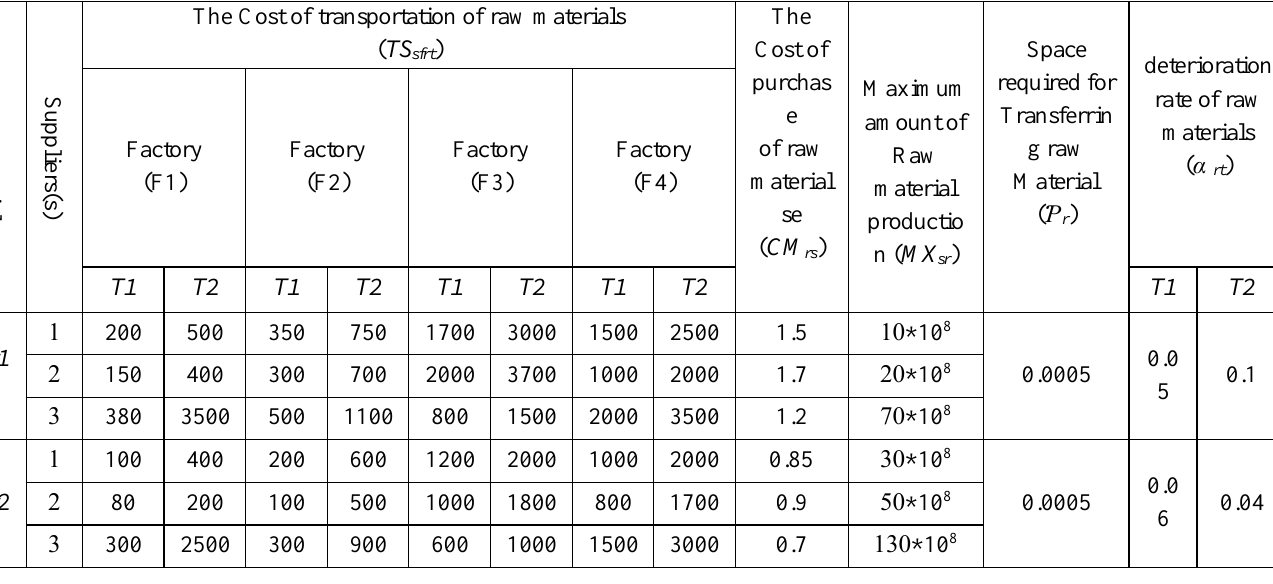
Table 2- The costs of transportation end product from factory to customer and raw materials needed per unit